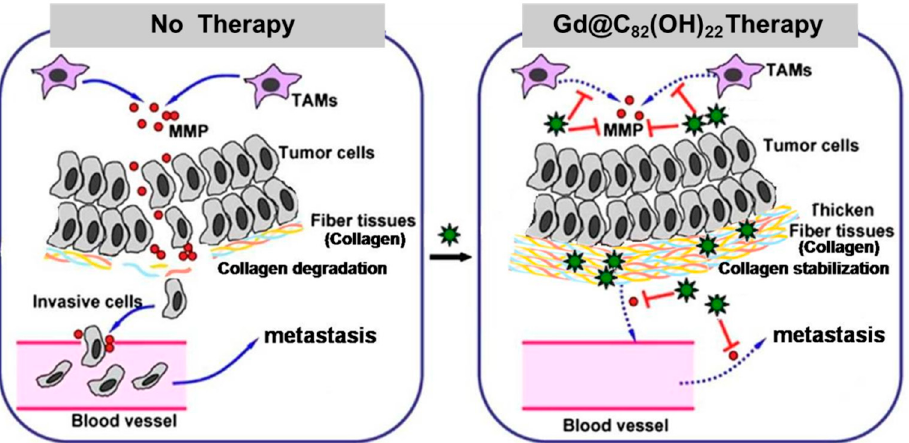
Figure 2. Schematic presentation of tumor encaging by Gd@C 82 (OH) 22 . Instead of directly poisoning tumor cells, Gd@C 82 (OH) 22 encaged tumor via MMP inhibition and collagen stabilization. In the control mice (left panel), MMP secreted by tumor-associated macrophages (TAMs) efficiently degraded the collagen-consisting fibrous matrices. Consequently, tumor cells escaped and tumor metastasis occurred. In Gd@C 82 (OH) 22 -treated mice (right panel), Gd@C 82 (OH) 22 decreased MMP production and activity and furthermore stabilized collagen by facilitating the formation of collagen microfibrils. The formed thick fibrous layers imprisoned tumor cells and the tumor failed to metastasize. ( represents Gd@C 82 (OH) 22 molecule). Adapted with permissions from Meng, H, Nanomedicine; published by Elsevier Inc. 2012.